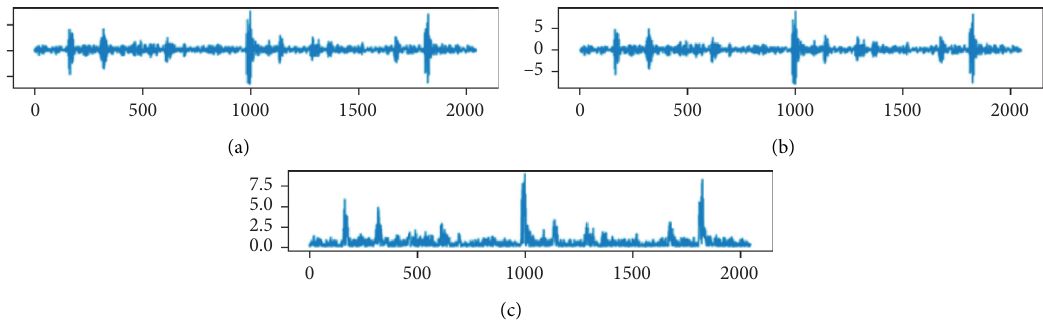
Figure 10: 0.014-inch IR fault.